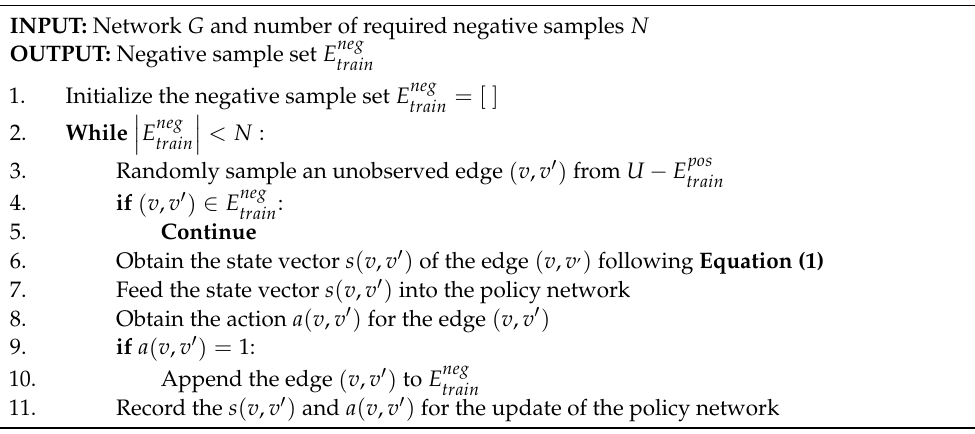
Algorithm 1: The negative sampling procedure with the negative sample